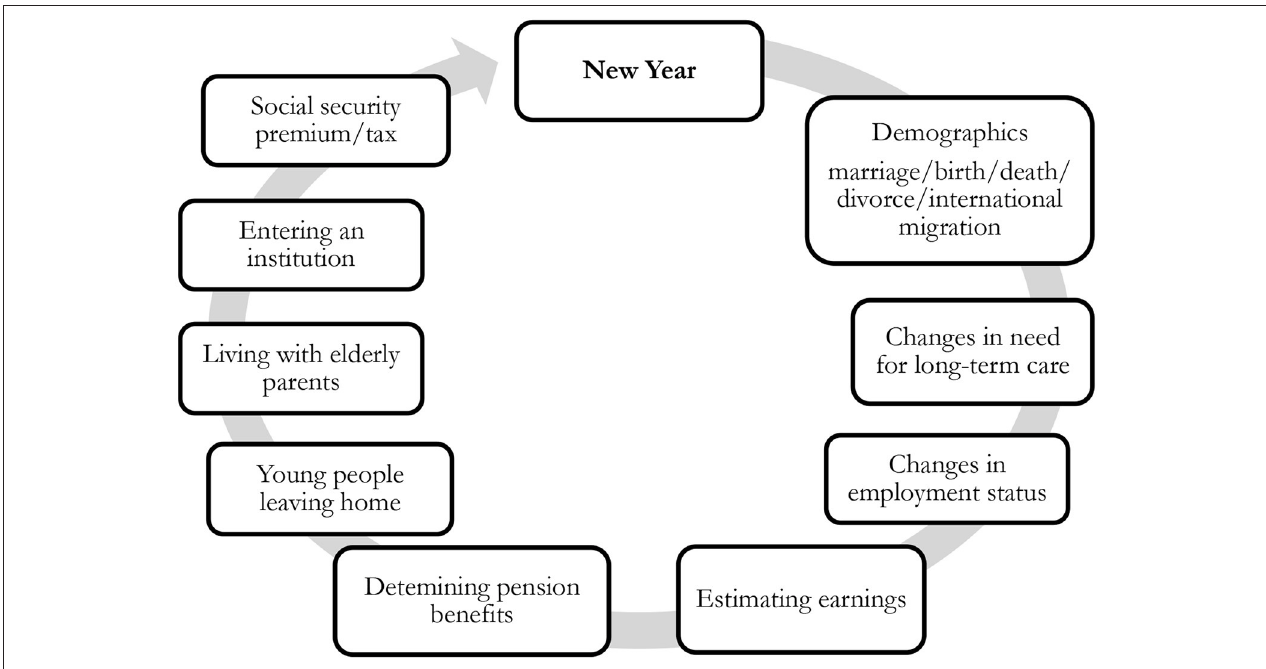
FIGURE 2 | INAHSIM simulation cycle. Source: Inagaki [2].